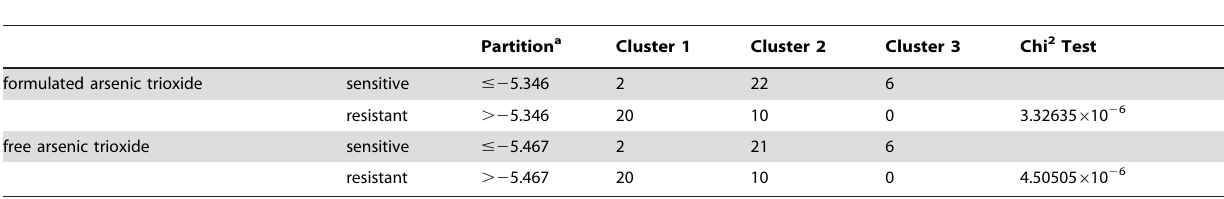
Table 2. Separation of clusters of the NCI cell line panel obtained by the hierarchical cluster analysis shown in Figure 3 in comparison to drug